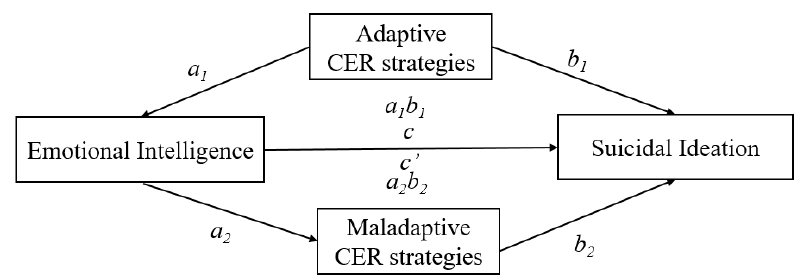
Figure 1. Illustration of the parallel multiple mediation model (Model 4; Hayes, 2018). Note. CER= cognitive emotion regulation.